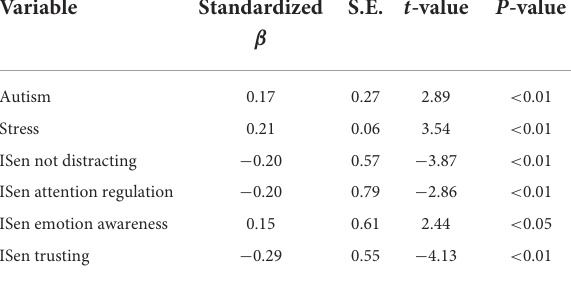
TABLE 7 Regression model summary where alexithymia is the